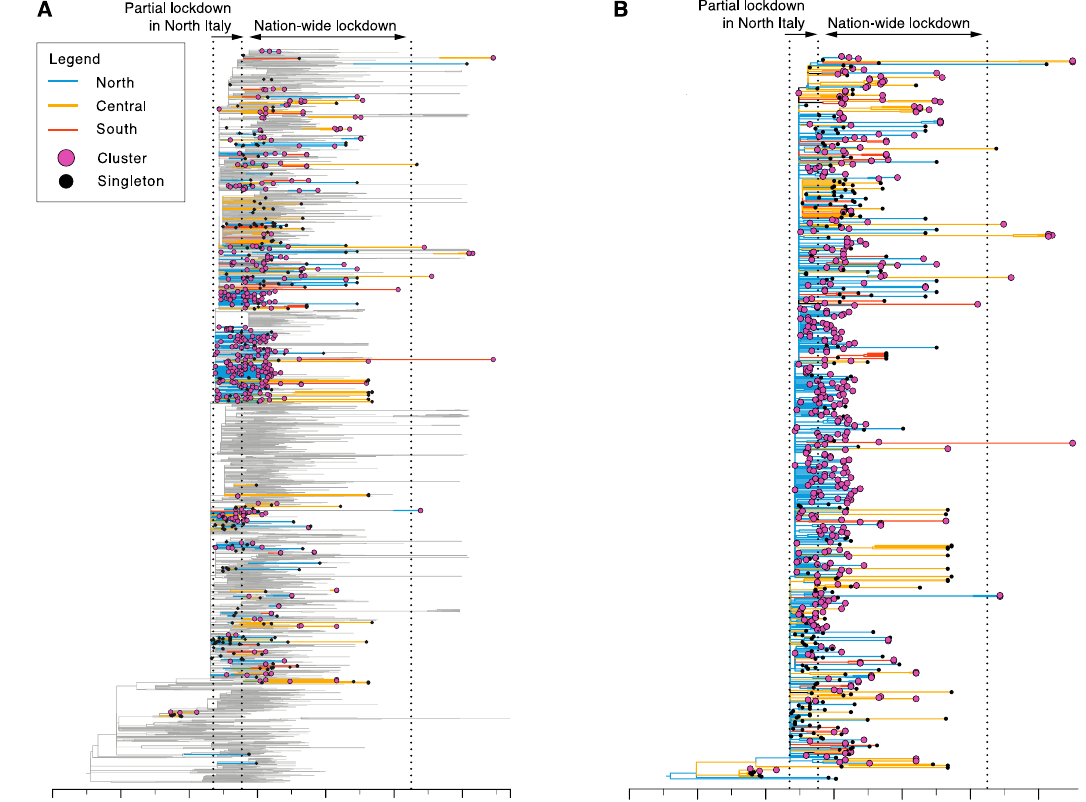
Figure 3. Identification of transmission clusters in Italy. The figures depict time-trees with branch lengths proportional to time in years. Branches are coloured according to geographic territory; blue = North Italy, yellow = Central Italy, red = South Italy. Tip circles are coloured according to clustering type; clusters = pink, singletons = black. Lockdown periods are marked by dotted lines. ( A ) Global tree, ( B ) Italian sequences extracted from global tree.